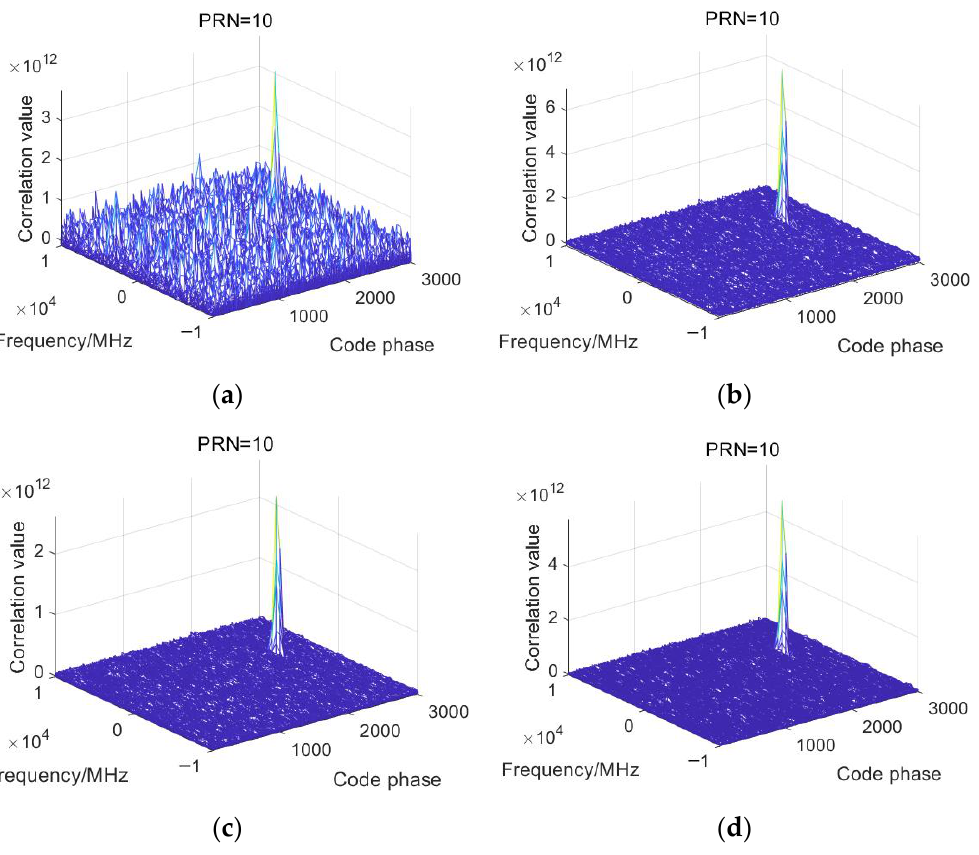
Figure 7. SIR = −22 dB, acquisition effect of the four algorithms: ( a ) coherent integration; ( b ) coherent and non-coherent integration; ( c ) differential coherent integration; and ( d ) improved differential coherent integration.